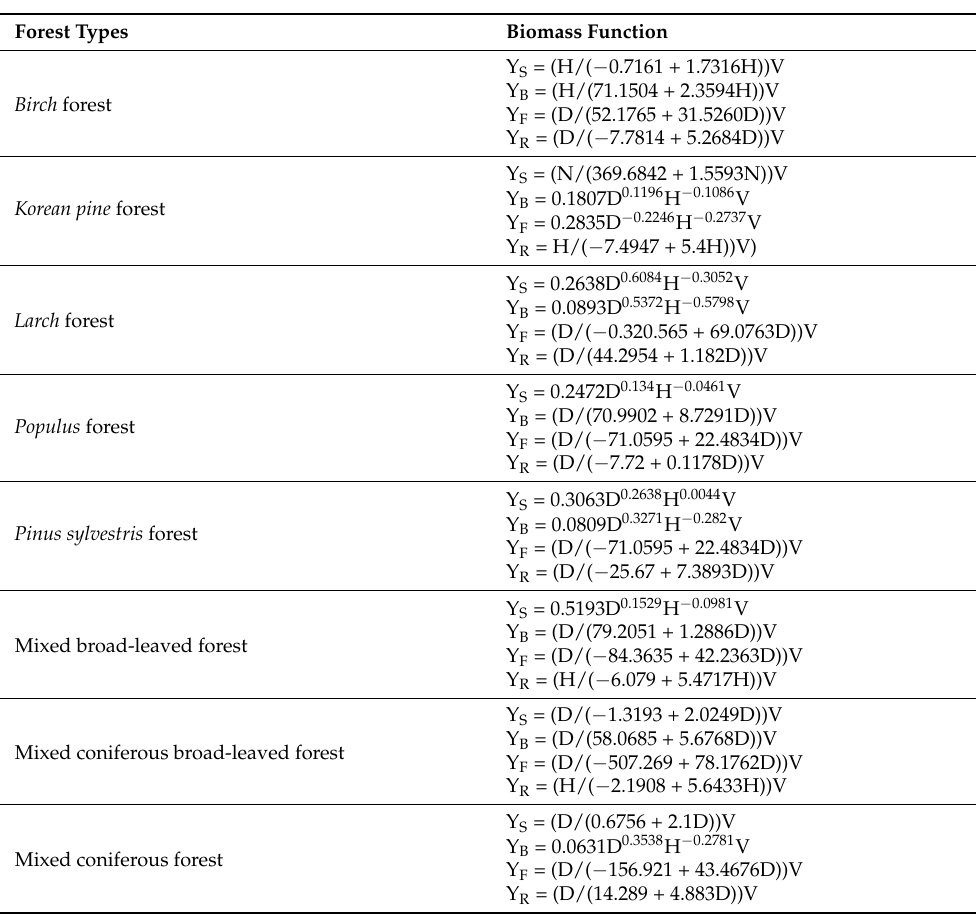
Table 1. Equations used for estimating the biomass of the different forest stands from the Xiaoxingan- ling Mountains following Dong 2015 [30]. In these equations, H is the average tree height (m), D is the average diameter at breast height (cm), N is the stand density (n/ha) and V is the storage volume (m 3